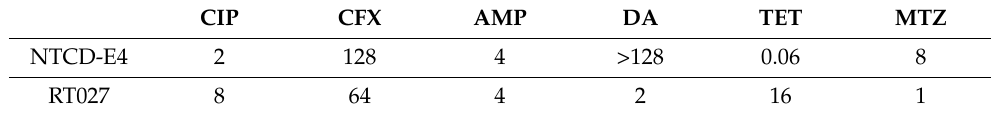
Minimum inhibitory concentrations (MIC, mg/L) of antimicrobial agents using a Wilkins–Chalgren agar incorporation method. Bacterial inocula were cultured in Schaedler’s anaer- obe broth and inoculated onto agar using a multi-point inoculator (10 4 cfu/spot). CIP, ciprofloxacin; CFX, cefotaxime; AMP, ampicillin; DA, clindamycin; TET, tetracycline; MTZ,